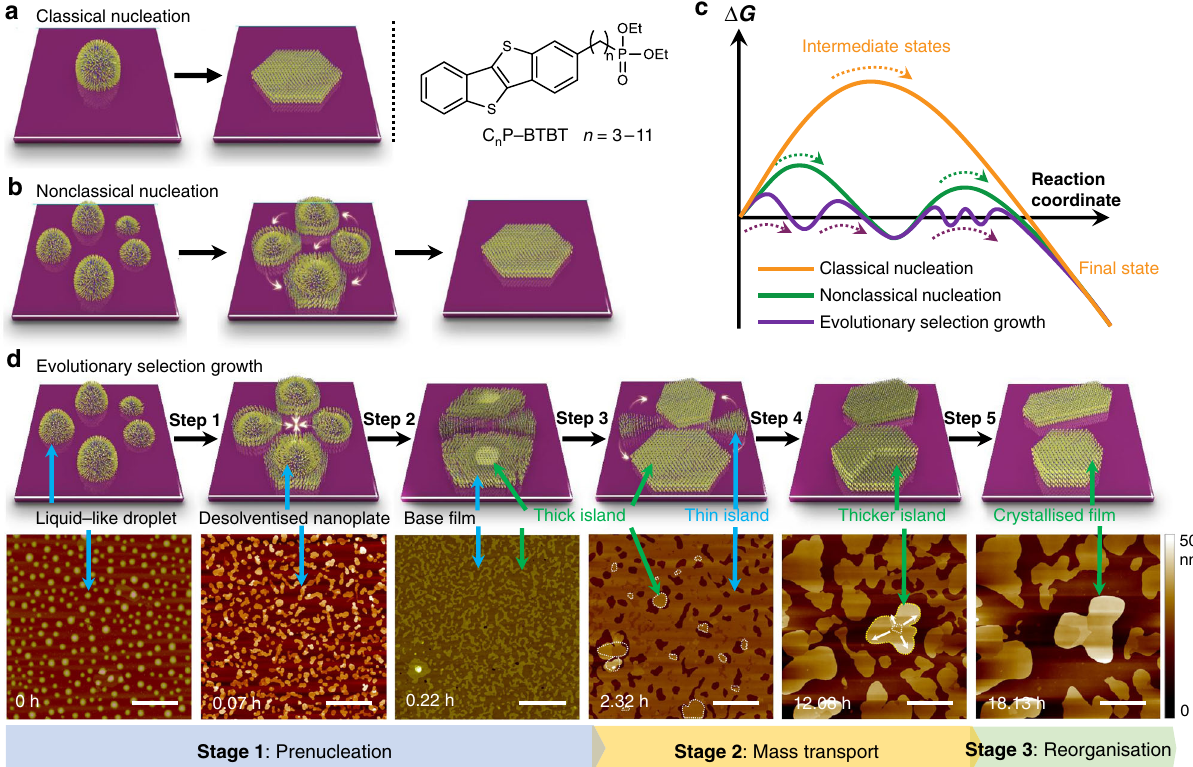
Fig. 1 Five-step biomimetic self-assembly trajectories of C 7 P-BTBT on the SiO 2 surface. a Classical monomer-by-monomer addition (left) and the structure of C n P-BTBT ( n = 3 – 11) (right). b Nonclassical two-step coalescence mechanism. c Plots of the free energy change as a function of reaction coordinate in classical (orange), nonclassical (green) and evolutionary selection (purple) growth models. d Evolutionary selection growth approach and time-lapse sequence of representative AFM images showing the morphological evolution of the precursors on the SiO 2 surface. From left to right, the images were taken at 0 h (as-spin coated liquid-like droplets), 0.07 h (droplets fl attened into pancake-like nanoplates), 0.22 h (nanoplates collapsed into fully covered base fi lm), 2.32 h (base fi lms demixed into thick islands and thin islands), 12.08 h (thin islands shrank while thick islands grew) and 18.13 h (thick islands grew vertically into a crystallised fi lm). Scale bar: 2 µ